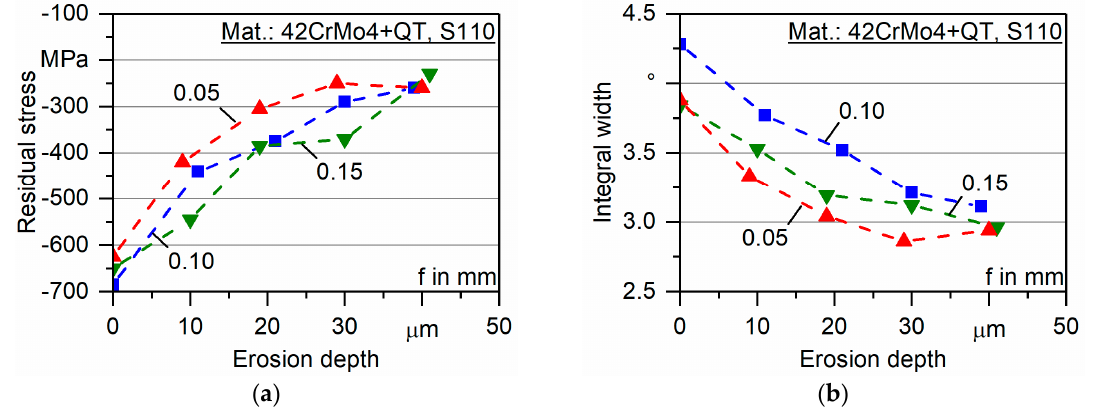
Figure 9. Results of XRD measurements of S110 specimen drilled with varying feed rate ( a ) residual stresses; ( b ) integral width.